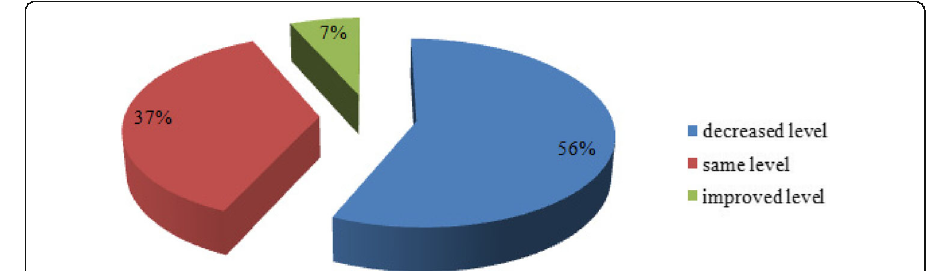
Fig. 4 Distribution of Behavior Level